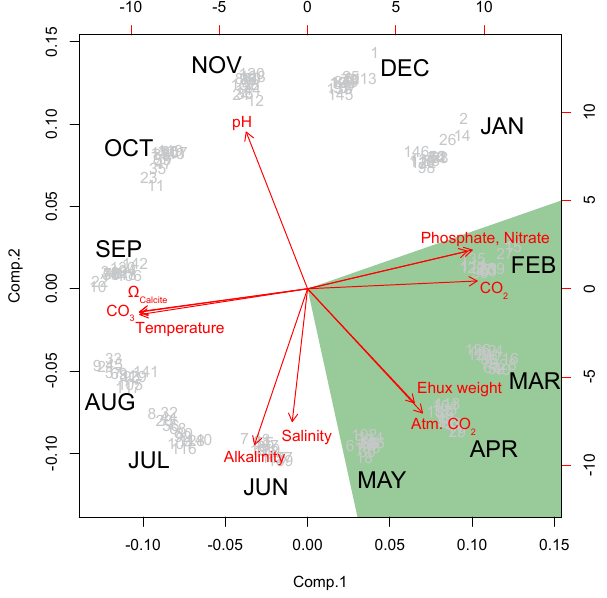
Figure 6. PCA of the combined seasonal and trend data from the SSA. The first PCA axis explains 62% of the variance, the second axis 31%. The data clusters in months (represented by grey num- bers) and the arrows point in the direction of the maximum values. The main coccolithophore production season from February to May (Marty et al., 2002) is marked in green. At the beginning of the sea- son, nutrients and [CO 2 ] are highest, while temperature, [CO 2 − and (cid:127) Calcite are lowest. A 2-month lag between these initial condi- tions and the maximum in coccolith weight is observed.